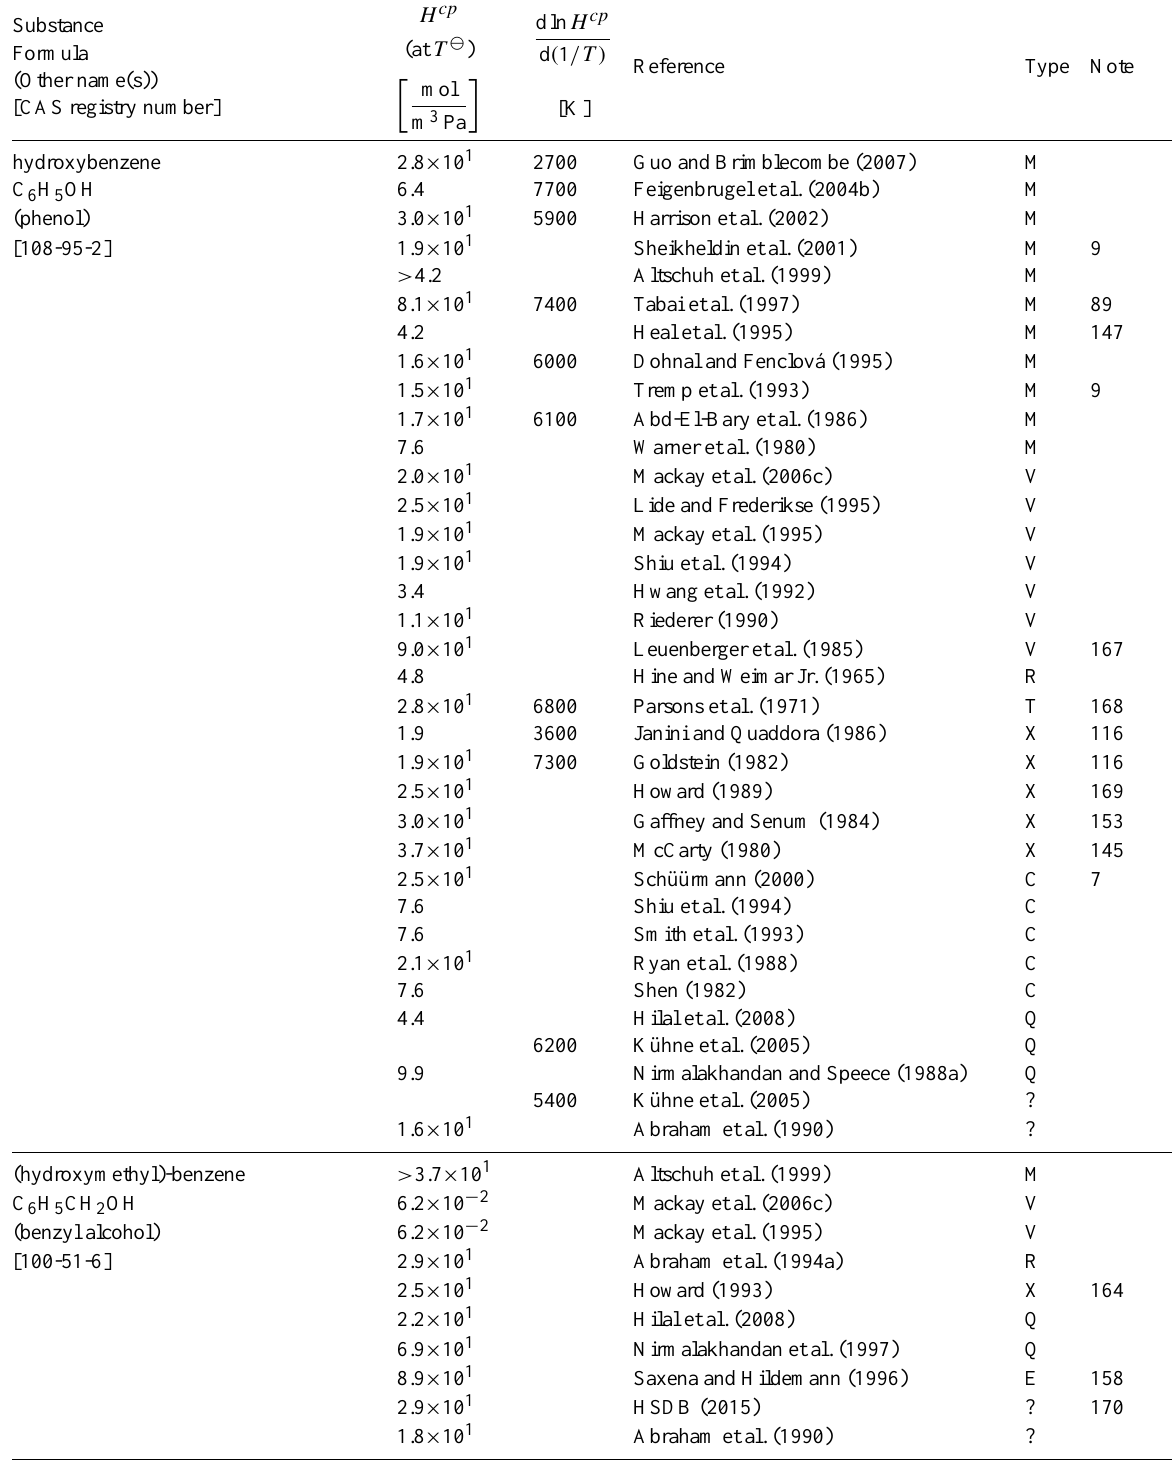
Table 6: Henry’s law constants for water as solvent